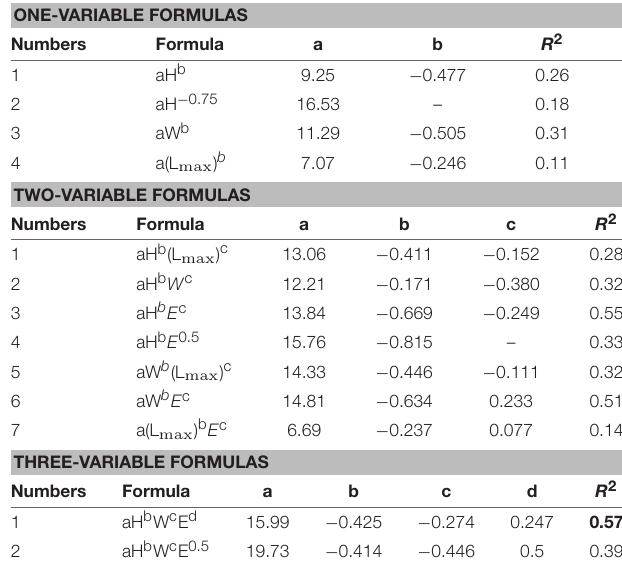
TABLE 5 | Results of the regression analysis for estimate the first frequency using one-variable, two-variable and three-variable formulas. ONE-VARIABLE